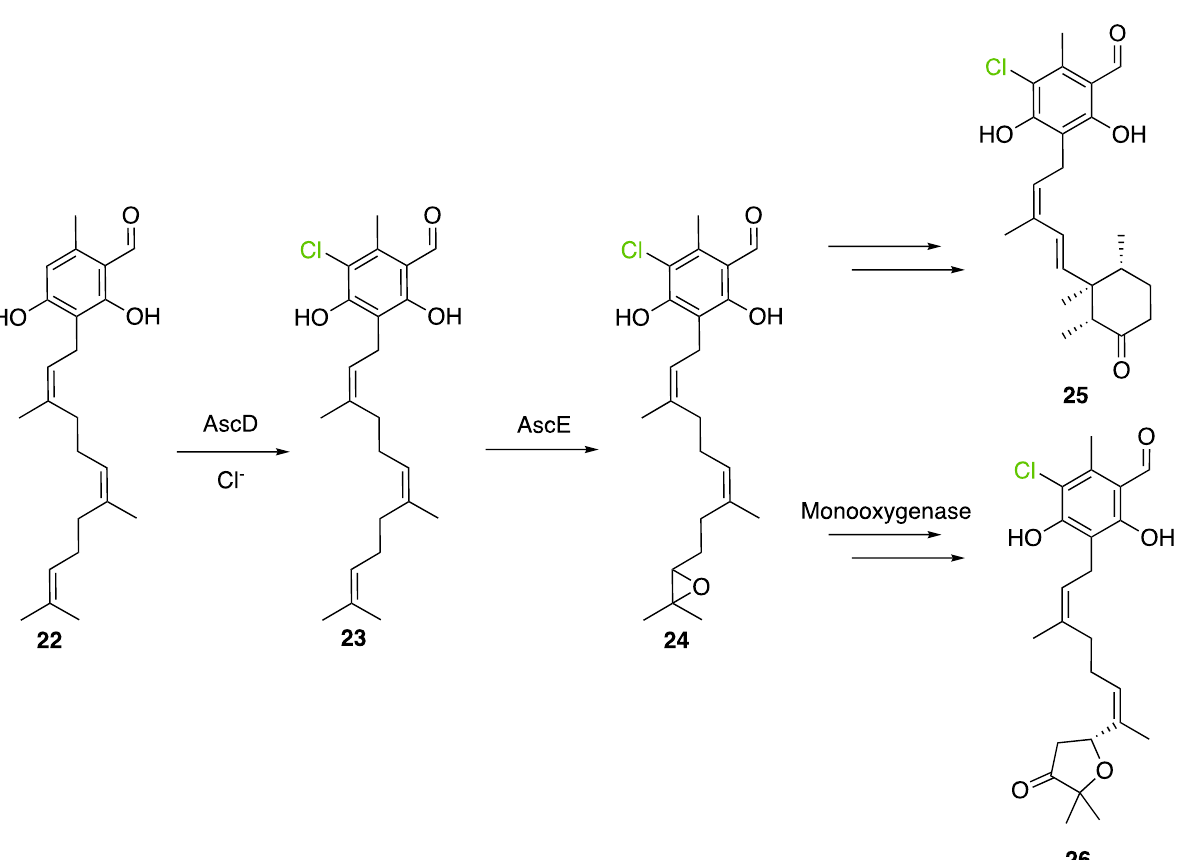
Figure 18. Chlorination of ilicicolin B ( 22 ) by AscD in A. egyptiacum to form ilicicolin A ( 23 ) and then the epoxide form ( 24 ) in the biosynthesis of ascochlorin ( 25 ) and ascofuranone ( 26 ).